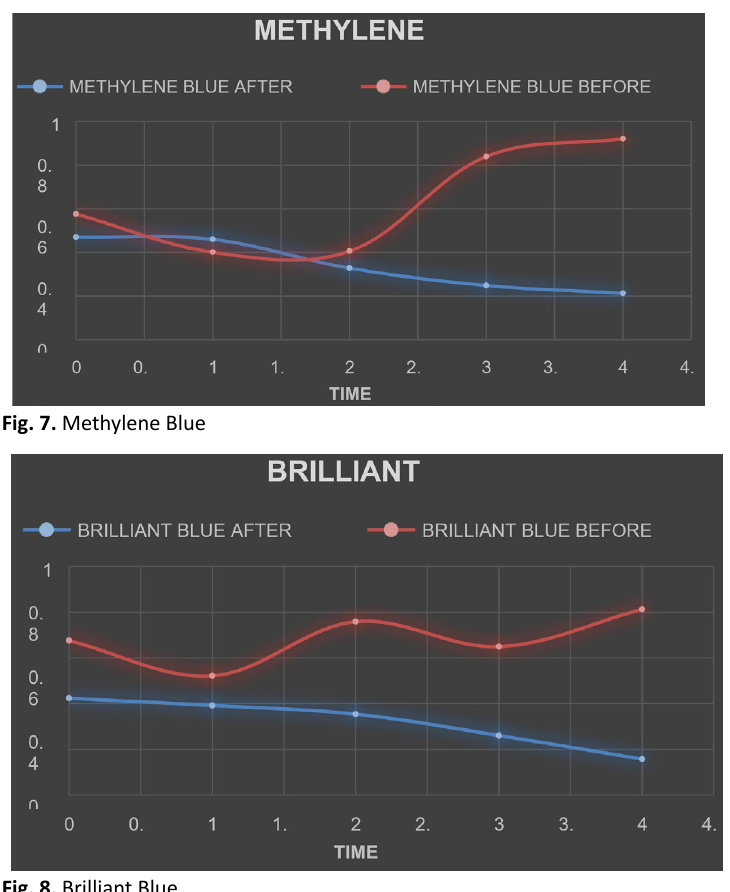
Fig. 8. Brilliant Table 8. Absorbance of the dyes before Treatment